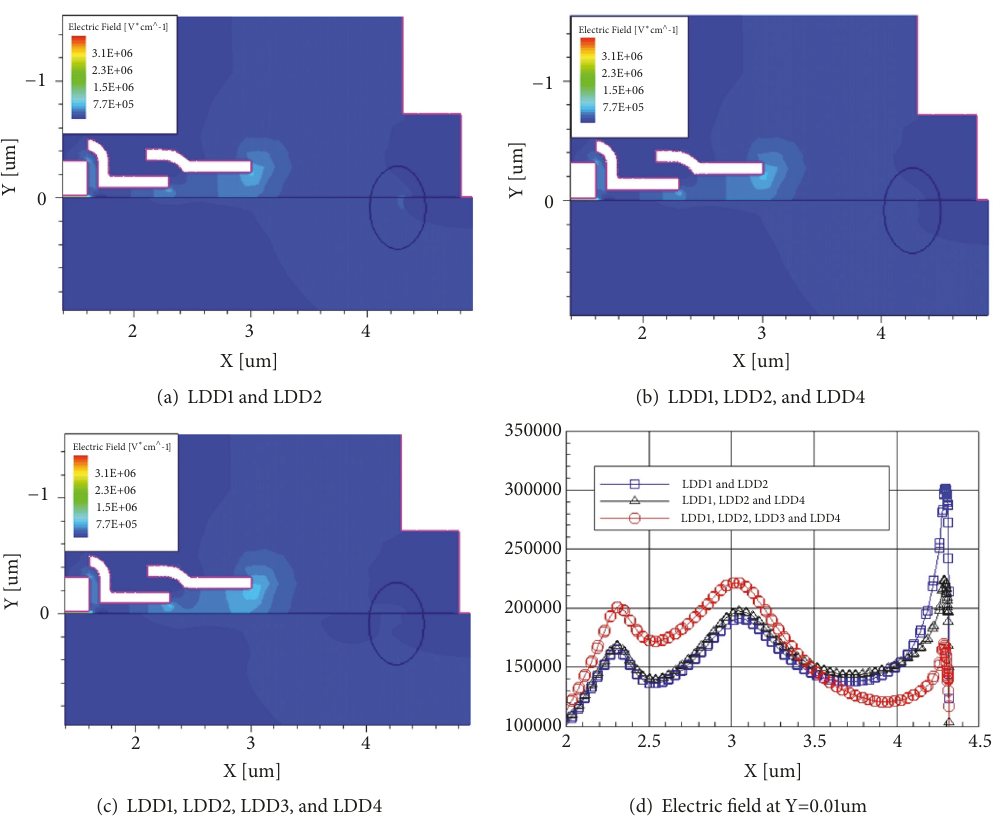
Figure 6: Electric field distribution of device with different LDD structure.